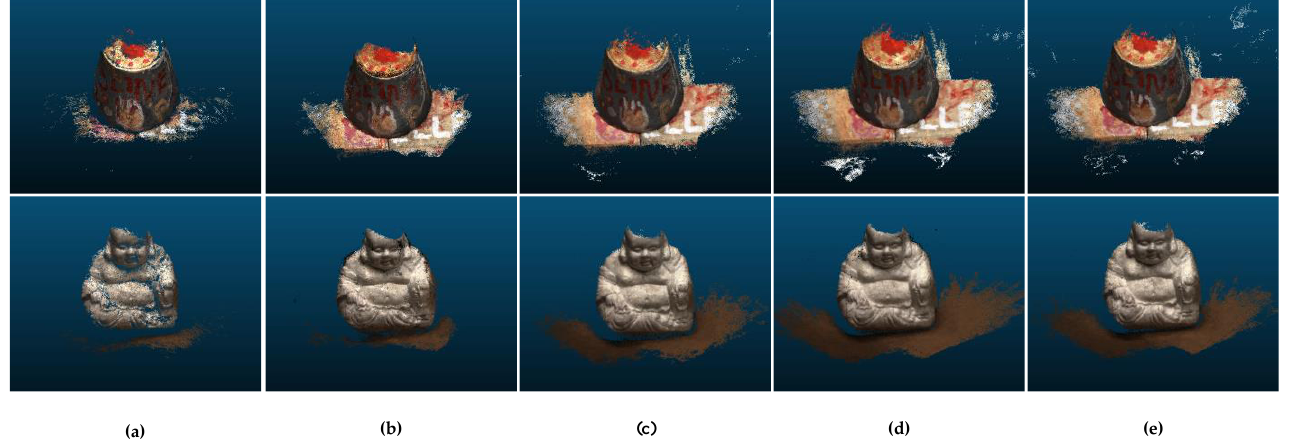
Figure 5. Comparison of reconstructed results. ( a ) AA-RMVSNet; ( b ) CasMVSNet; ( c ) CVPMVSNet; ( d ) AACVP-MVSNet; ( e ) Ours.